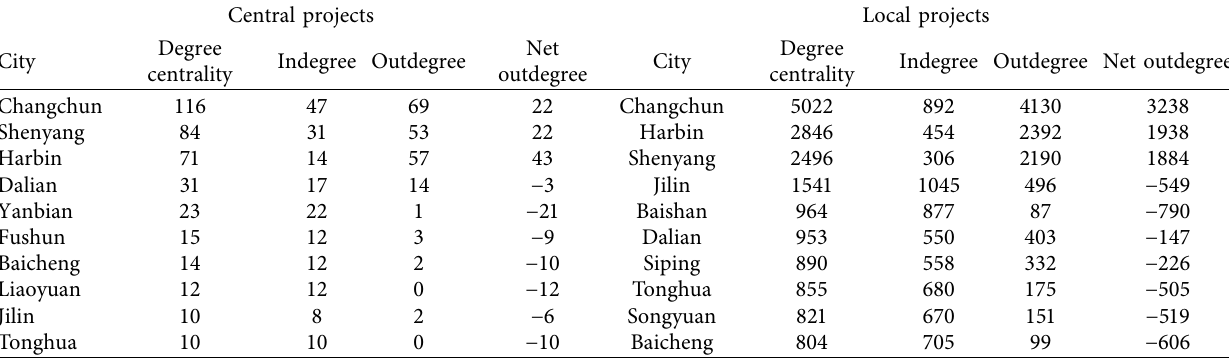
Table 5: Degree centrality of the top 10 cities in the regional